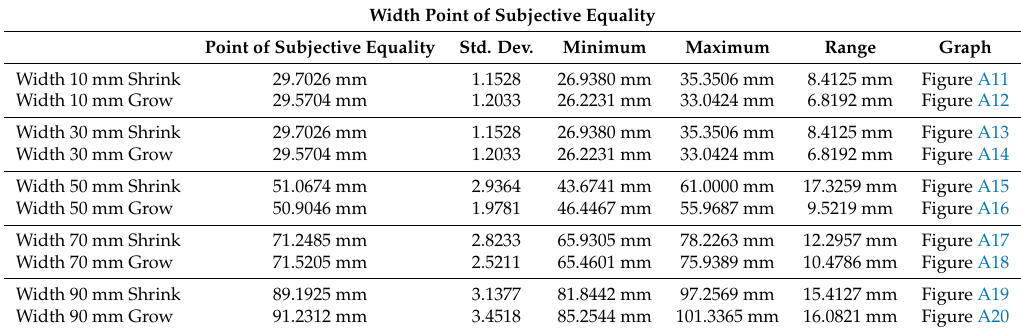
Table 4. Width judgement for tasks of 10 mm to 90 mm for height point of subjective equality. Width Point of Subjective Equality Point of Subjective Equality Std. Dev.